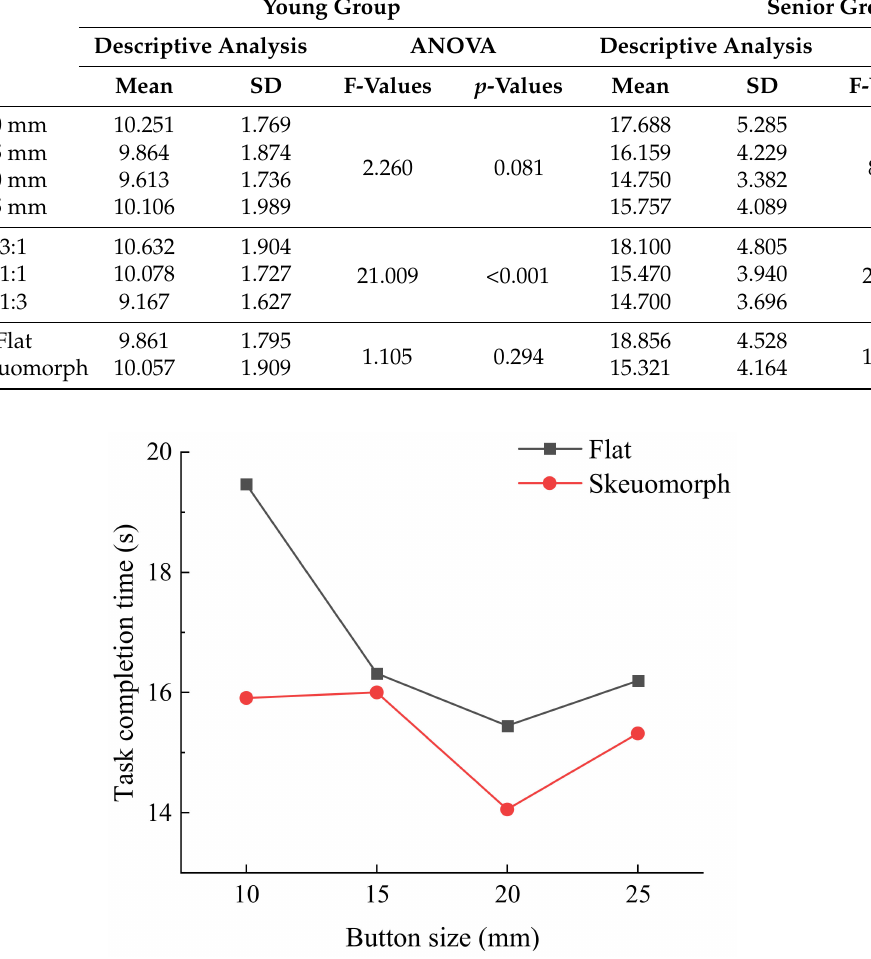
Figure 2. Task completion time (s) by button size and icon style for senior